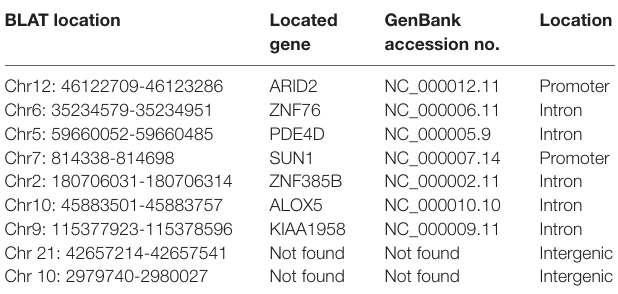
TABLE 2 | miR-373 binding sequences identified by Sanger